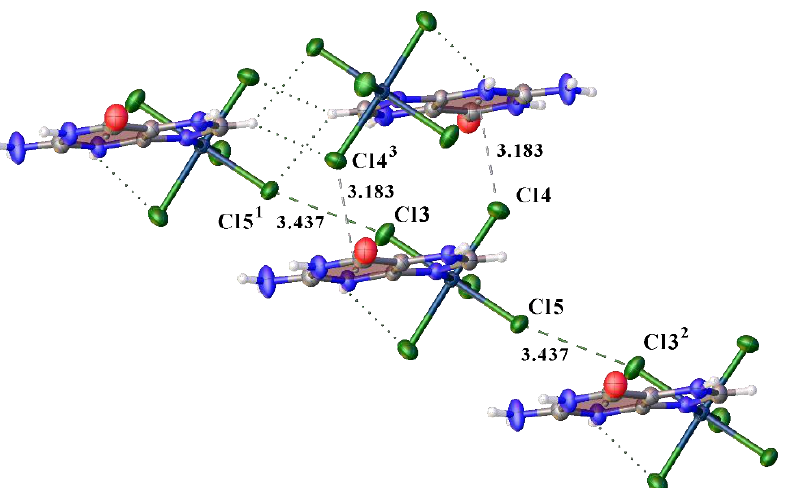
Figure 9. View showing π -halogen interactions and halogen bonds with bond lengths within and between columns respectively in 2 .